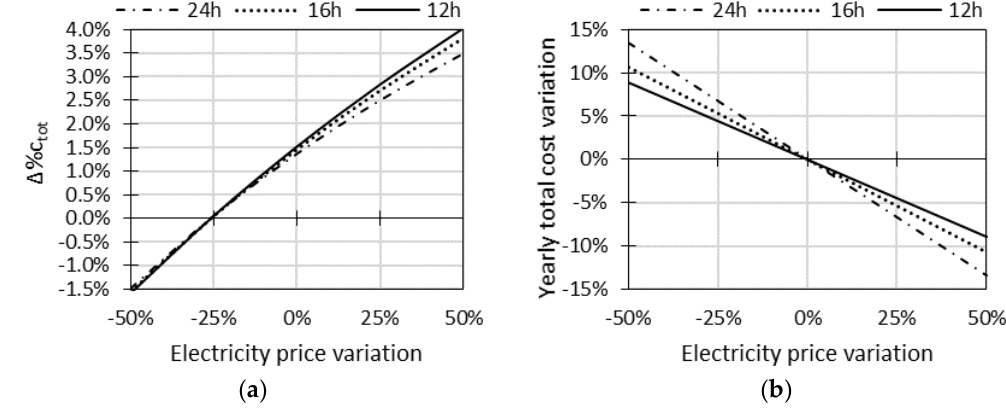
Figure 9. Sensitivity analysis on electricity price: ( a ) yearly cost variation of warehouse with PV plant as compared to one without PV installation; ( b ) yearly cost variation of warehouse with PV plant.